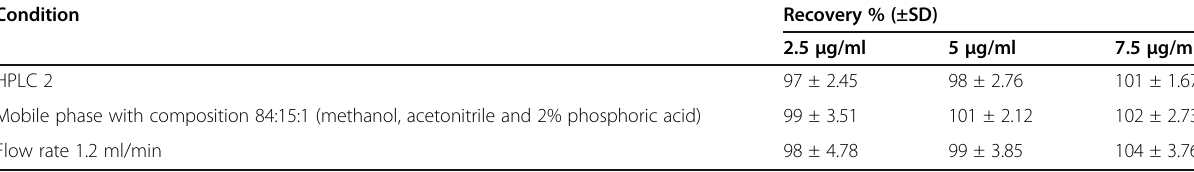
Table 6 Robustness results at different conditions